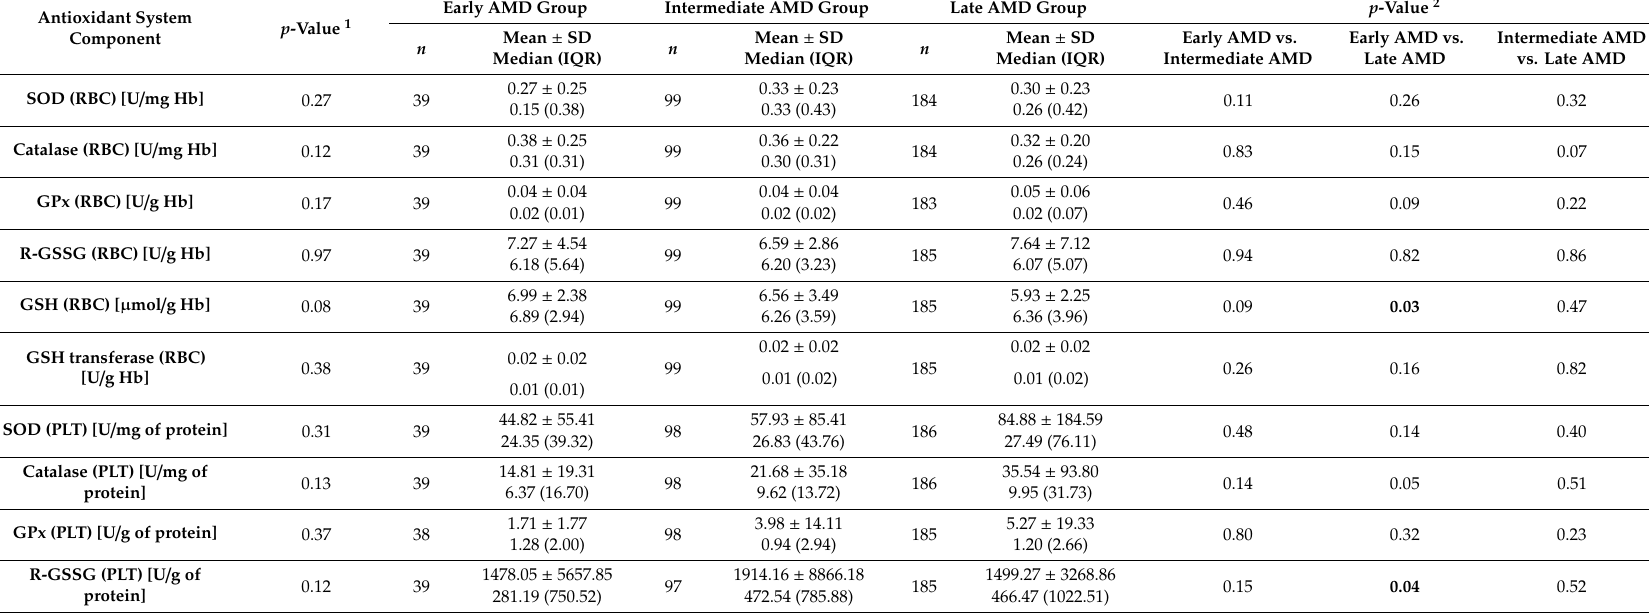
Table 5. Comparison of levels of components of the antioxidant system in patients with early, intermediate and late AMD. p -values < 0.05, which were considered statistically significant, are shown in